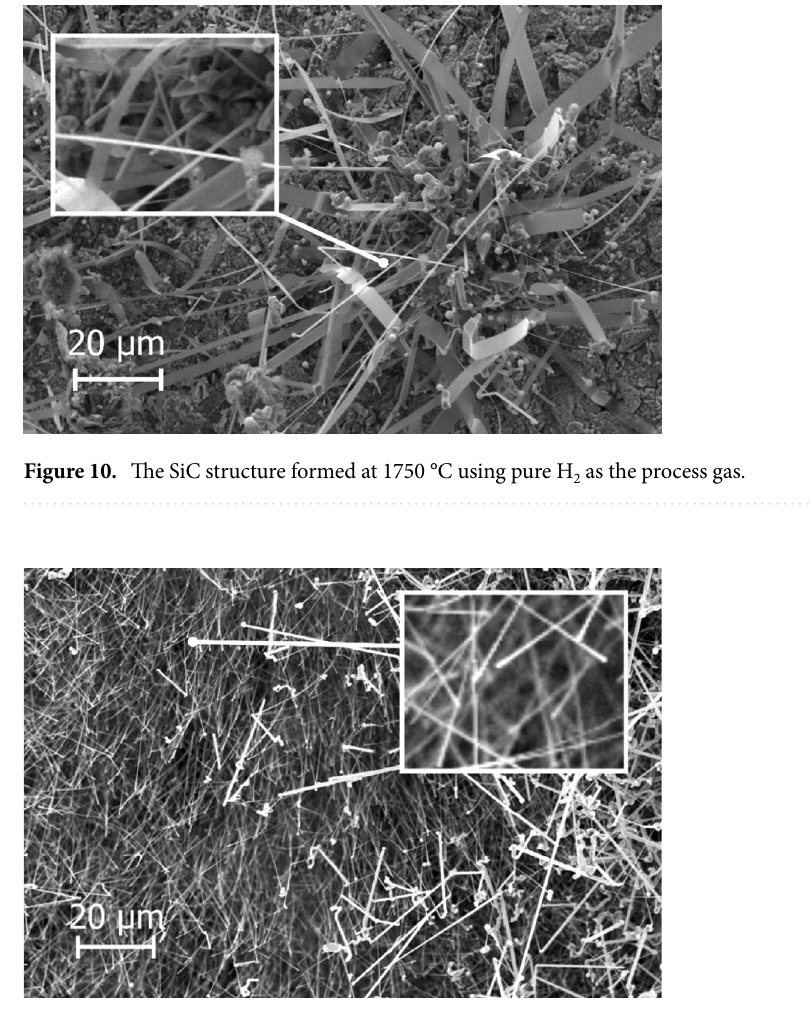
Figure 11. The SiC structure formed at 1650 °C using 2% CH 4 in H 2 as the process gas.